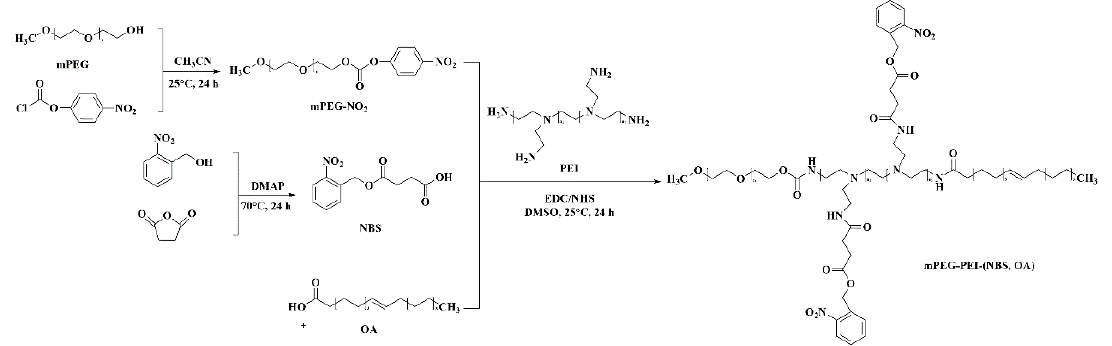
Pharmaceutics 2020 , 12 , x FOR PEER REVIEW Figure 2. Synthetic route of OA copolymer mPEG-PEI-(NBS, OA). Figure 2. Synthetic route of OA copolymer mPEG-PEI-(NBS, OA).